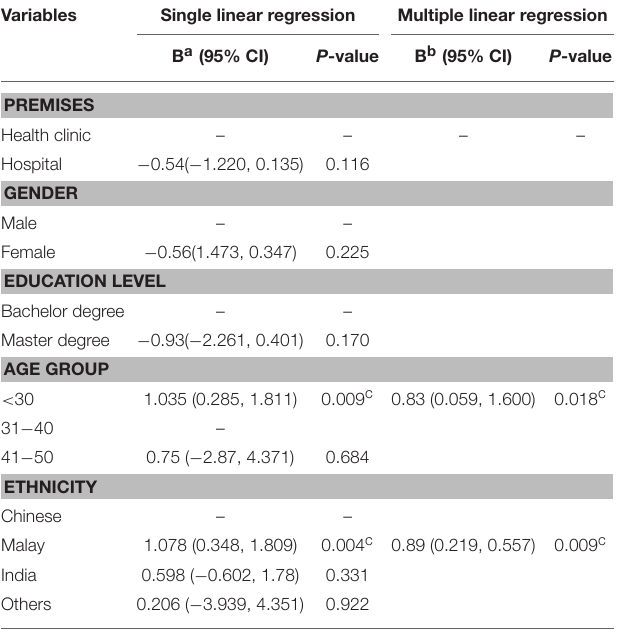
TABLE 3 | Regression model predicting knowledge of AD among pharmacists.